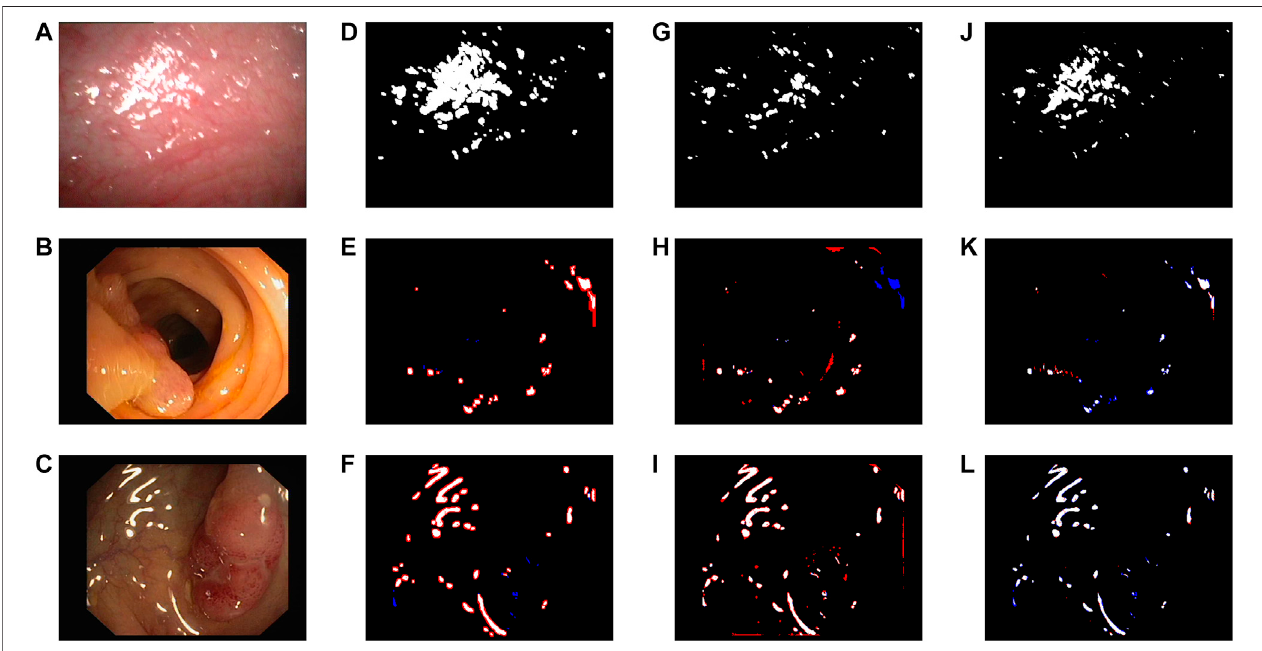
FIGURE 4 | Comparison between different methods. (A) Original image from clinical data. (B) – (C) Original images from CVC-ClinicSpec. (D) – (F) [8]. (G) – (I) [13]. (J) – (L) Proposed method.